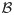
Clusters split by locations in France.Average yields, computed on the base B and the set of climates, are given above the bars.